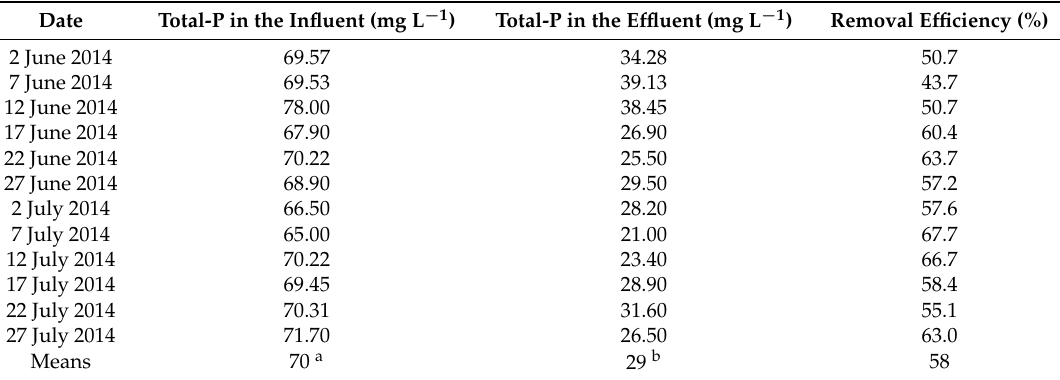
Table 5. Efficiency of a trickling filter in removing total phosphorous from an anaerobic digester